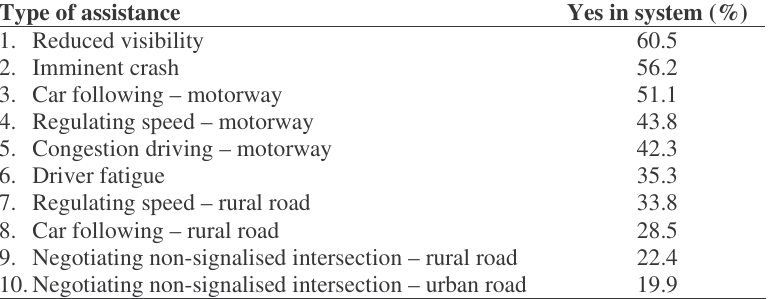
Table 4. Top 10 of most popular types of assistance in ideal